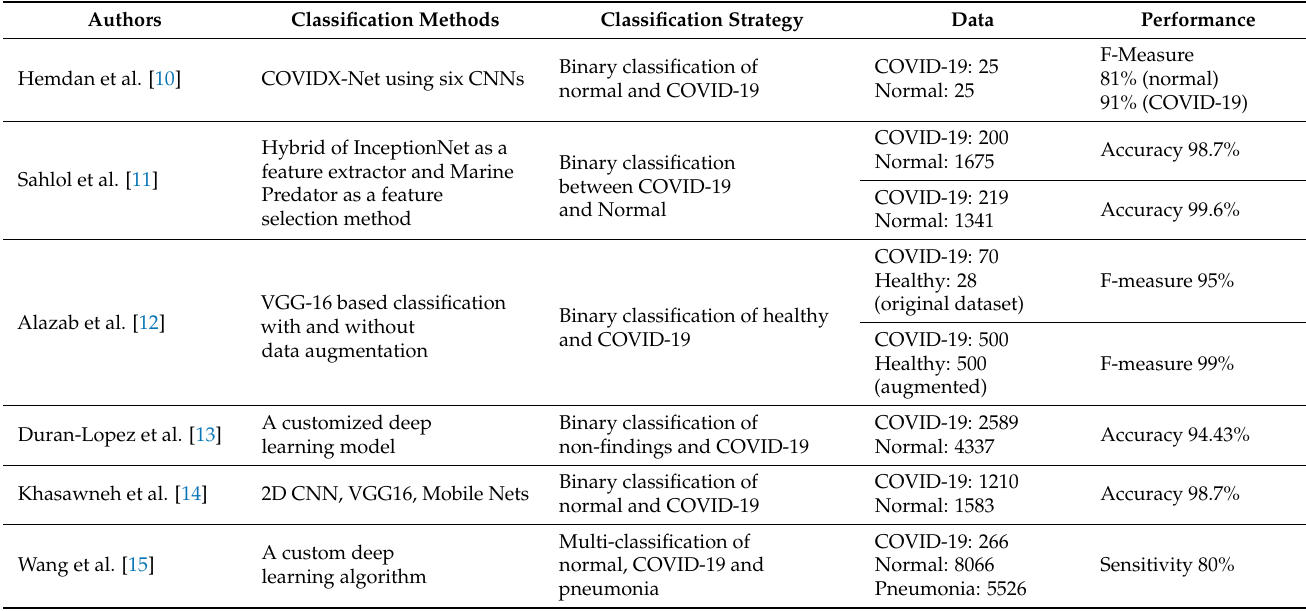
Figure 17. The indicative regions of COVID-19 biomarkers highlighted by DenseNet201. Table 12. Previous studies vs. our proposed